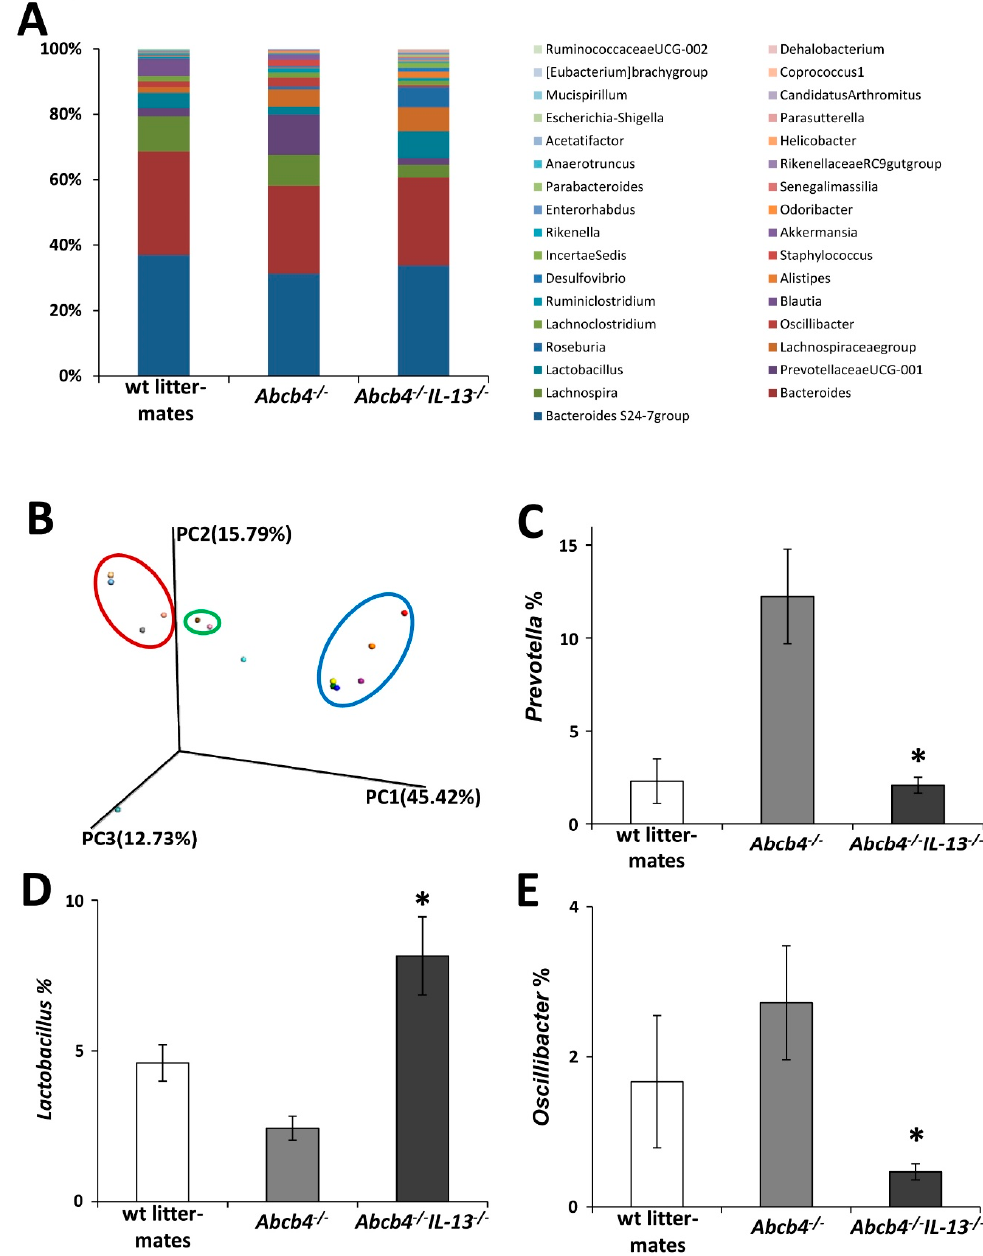
Figure 5. Beneficial change in intestinal microbiome in Abcb4 − / − / IL-13 − / − mice. Next-generation sequencing demonstrates alterations of the intestinal microbiome ( A ), while subsequent principle component analysis revealed characteristic and group specific compositions ( B ). Deleterious bacteria such as Prevotellaceae ( C ) and Oscillobacter ( E ) were raised in Abcb4 − / − mice and normalized by the additional IL-13 − / − , while beneficial microbiota such as Lactobacillae ( D ) were raised in Abcb4 − / − /IL-13 − / − mice in comparison to Abcb4 − / − . Values are means ± SEM. * p < 0.05 Abcb4 − / − vs Abcb4 − / − /IL-13 − / − .